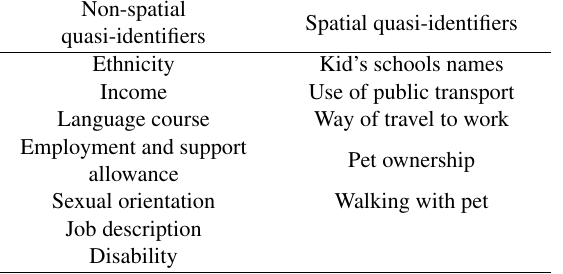
Table 1: Potential quasi-identifiers from the iMCD social survey.